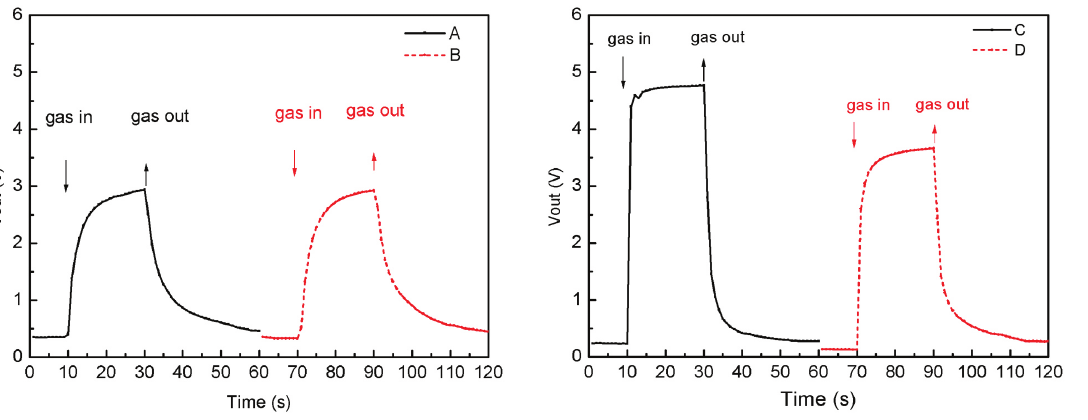
Figure 7. Curve A—pure ZnO under the visible light irradiation, Curve B—pure ZnO in dark.